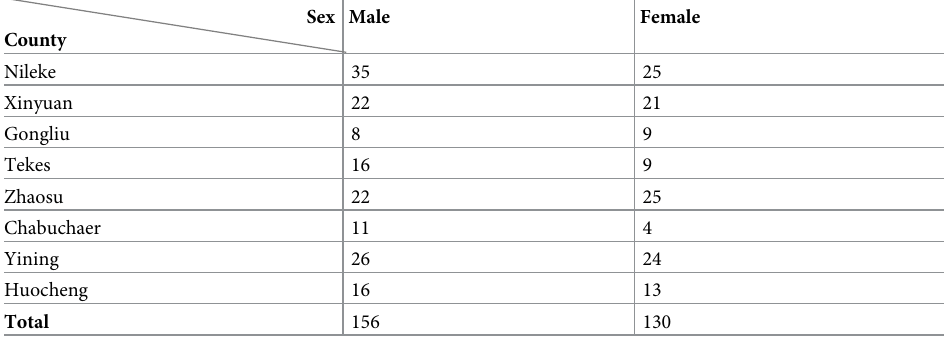
Table 4. Sex distribution of AE patients in the study counties.